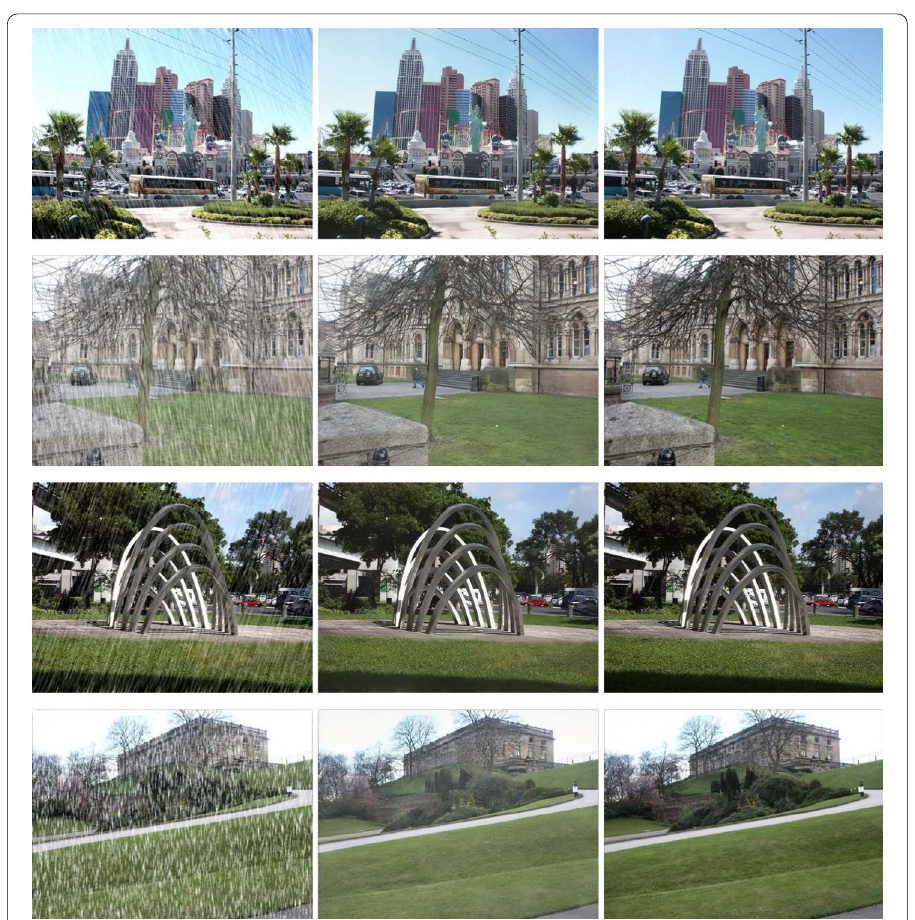
Fig. 8 De-raining results on the Rain800 dataset. From left to right: rained, Our de-raining, no-rain photograph